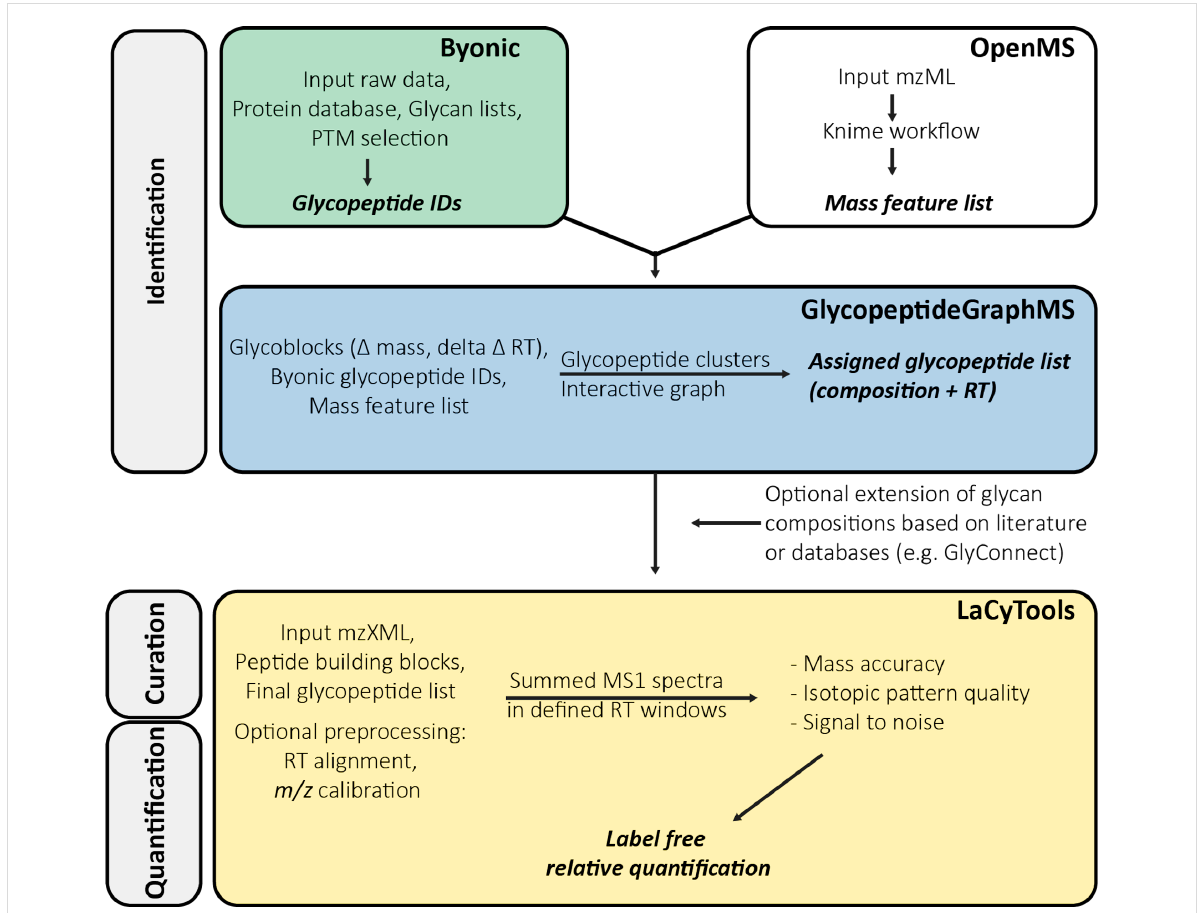
Figure 1: Integration of automated glycopeptide identification by Byonic and GlycopeptideGraphMS (aided by OpenMS) and subsequent analyte quality control and quantification by LaCyTools.